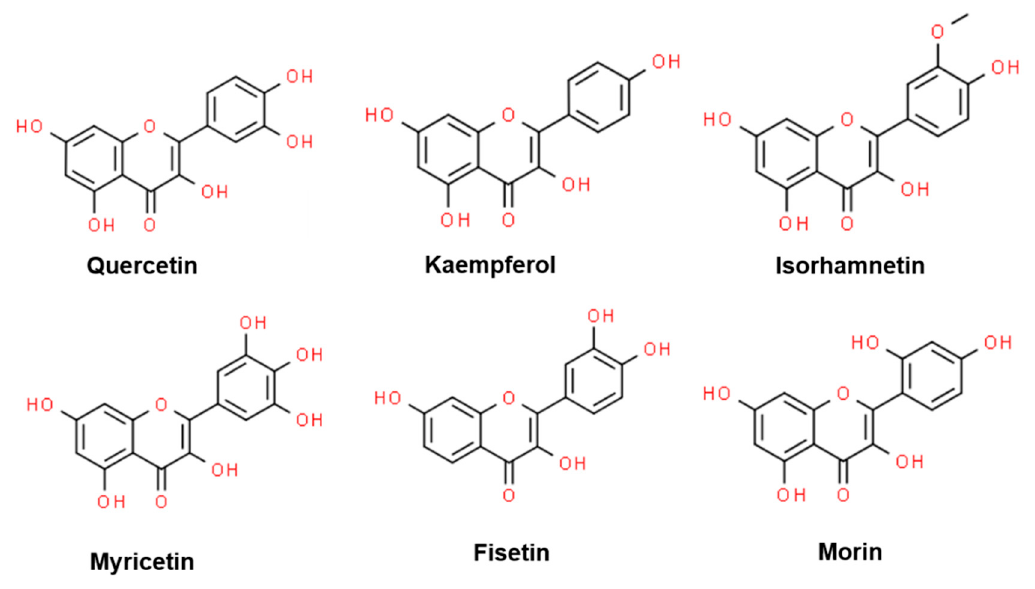
Figure 2. Chemical structure of the major representatives of flavonol aglycones in Allium spp. Table 2. Di ff erent kinds of flavonols and their glycosides identified in Allium species. S.